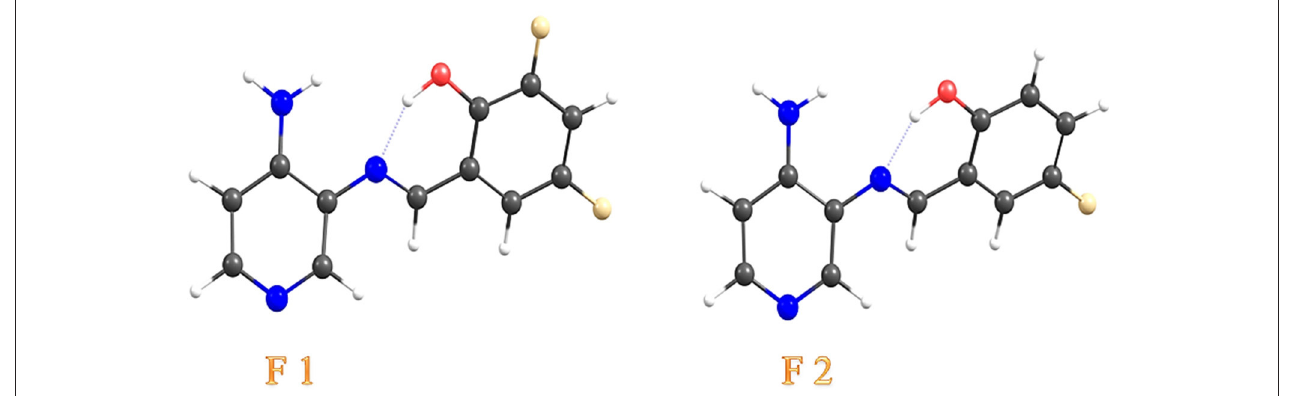
FIGURE 1 | Molecular models of the ( E )-2-[(3-Amino-pyridin-4-ylimino)-methyl]-4,6-difluoro-phenol ( F1 ) and ( E )- 2-[(3-Amino-pyridin-4-ylimino)-methyl]-6-fluoro-phenol ( F2 ), the two pyridine Schiff bases analyzed in this study.